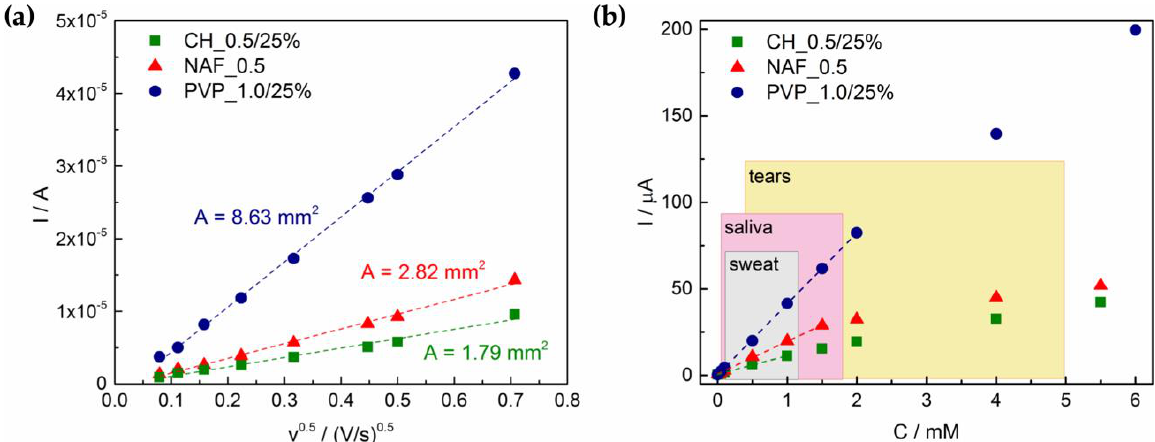
Figure 8. Characterization of the electrodes performance: ( a ) regression lines current versus square root of scan rate; ( b ) calibration plots in the concentration range 0−6 mM with marked linear ranges (dotted lines) and reported glucose levels in aimed biological fluids (boxes) [2].